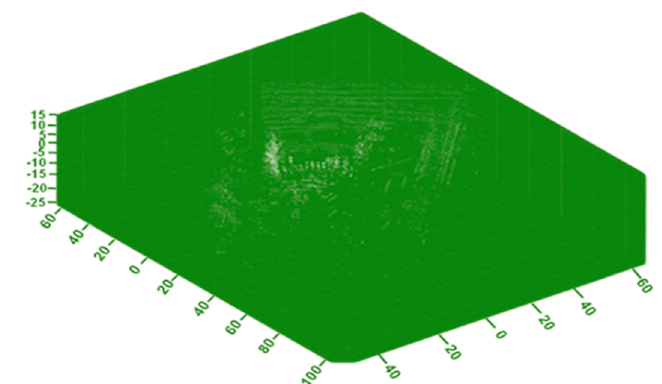
Figure 7. Segmented PC for 3D Object.